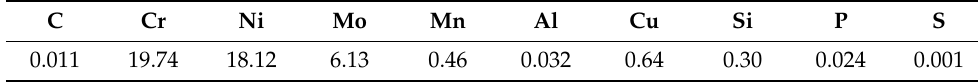
Table 1. Chemical composition of the S31254 SASS (in wt%). C Cr Ni